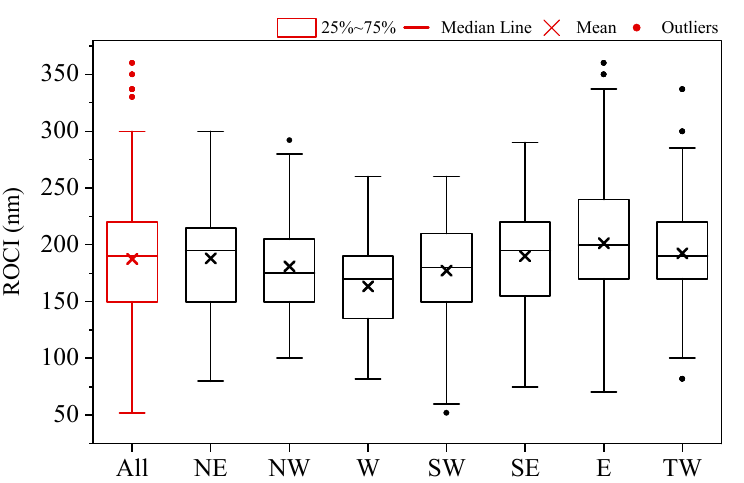
Figure 7. Box plot of ROCI (units: nm). The box with a red outline is for all samples in the study region, and those with black outlines are for samples in each subregion.